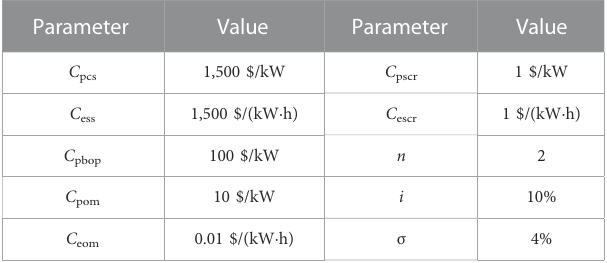
TABLE 1 Economic parameters of the energy storage system. Parameter